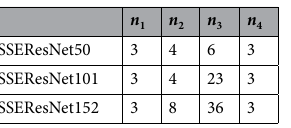
Table 1. SSEResNet regression model